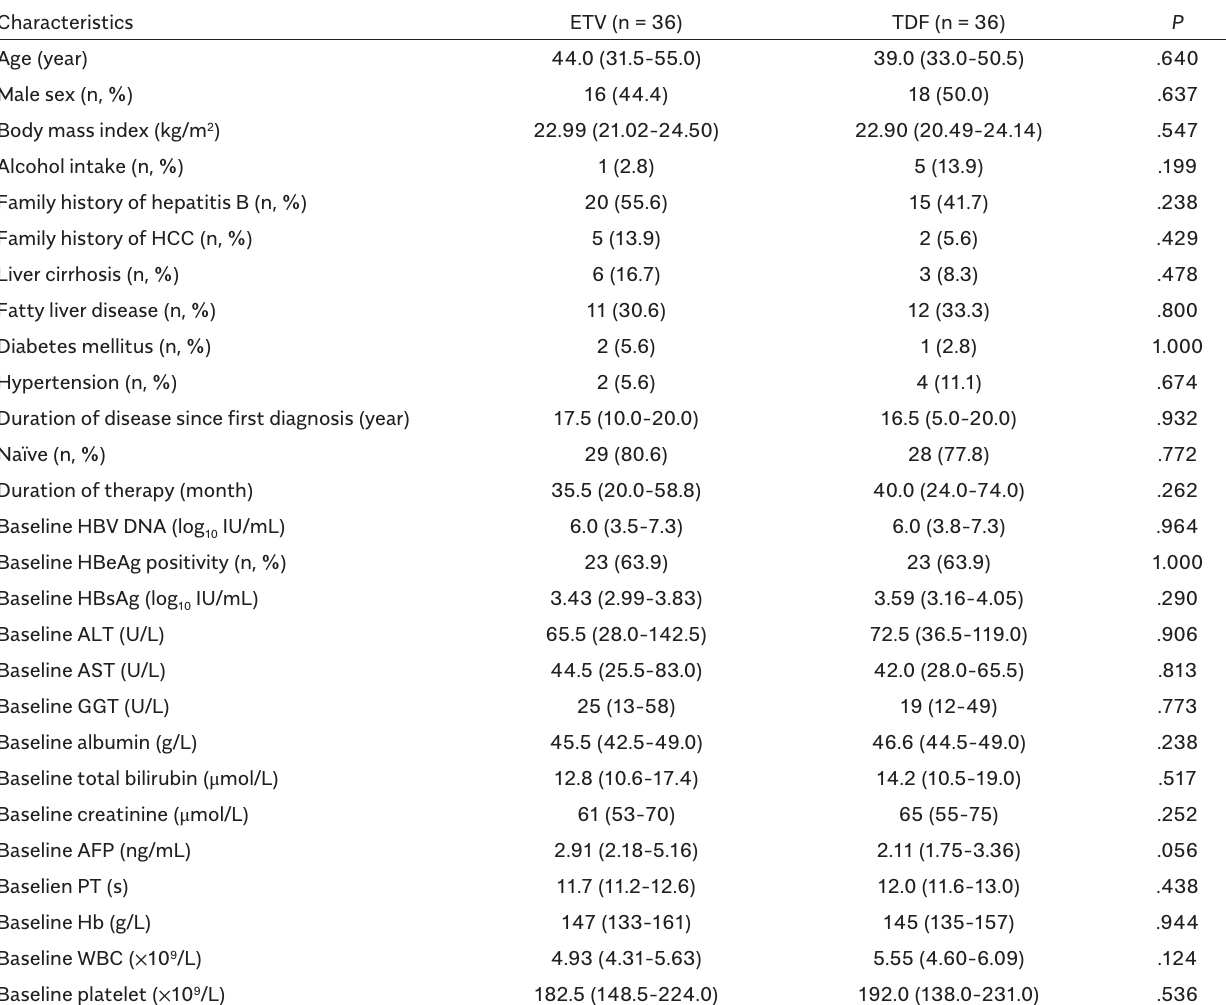
Table 3. Baseline Characteristics of the ETV and TDF Treatment Groups After PSM